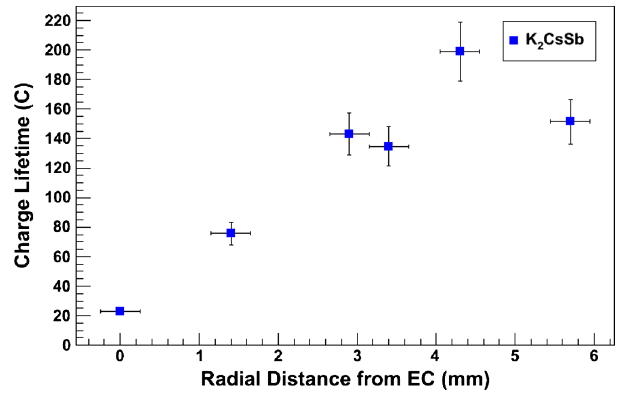
FIG. 7. Charge lifetime of K 2 CsSb photocathode #1 versus the radial position of the 532 nm laser spot relative to the electro- static center of the cathode. The vertical error bars are related to the quality of the exponential fit to the QE decay curves, and the horizontal error bars reflect uncertainty of the laser position relative the electrostatic center.